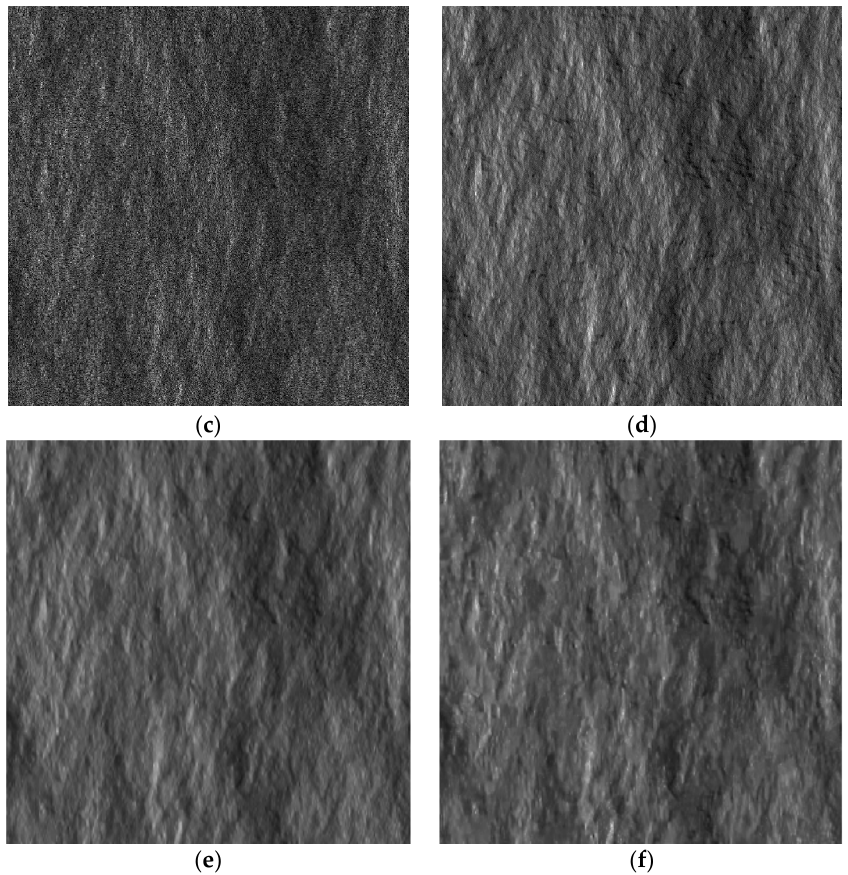
Figure 2. ( a ) Fractal DEM with fractal parameters H = 0.8, T = 10 − 5 m in the azimuth-slant range coordinate system; the resolution is 2.58 m and 2.29 m in the azimuth and slant range, respectively; ( b ) local incidence angle map in the azimuth-slant range coordinate system; ( c ) 512 × 512 single-look SAR image corresponding to the DEM in (a) and to the electromagnetic parameters ε r = 4 and σ = 10 − 2 S/m; ( d ) reference image obtained by averaging 512 single-look sample images; ( e ) SB-SARBM3D with a priori scattering information estimated from (b) and assuming the right values for the surface parameters; ( f ) SARBM3D. Table 1. Performance parameters of the reference image. VoR, Variance of Ratio; C x , Coefficient of variation; MSSIM, Mean Structural Similarity Index Measure; SPM, Small Perturbation Method.